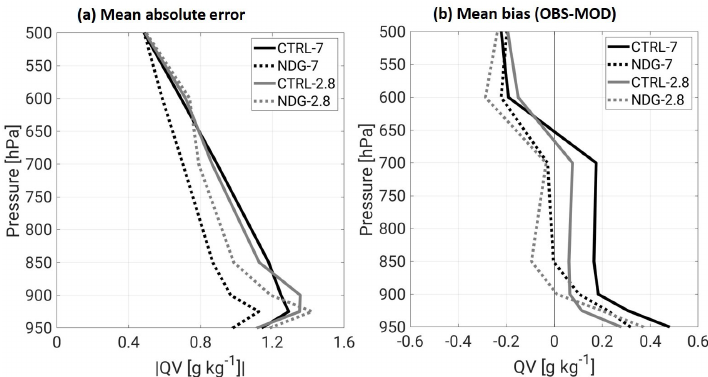
Figure 10. Validation of the model representation of the vertical distribution of specific humidity quantified by the mean absolute error (a) and the mean bias as the OBS-MOD (b) . All model values are validated against the radiosondes available in the period 26 October at 00:00UTC to 28 October at 00:00UTC at the seven stations within the 2.8km simulation domain (see red box in Fig. 1). All model values have been interpolated to the location of the radiosonde station from the nearest neighbours, and the vertical specific humidity values have been interpolated to 11 pressure levels between 950 and 500hPa. No values are shown below 950hPa given the lack of available data for several stations below this